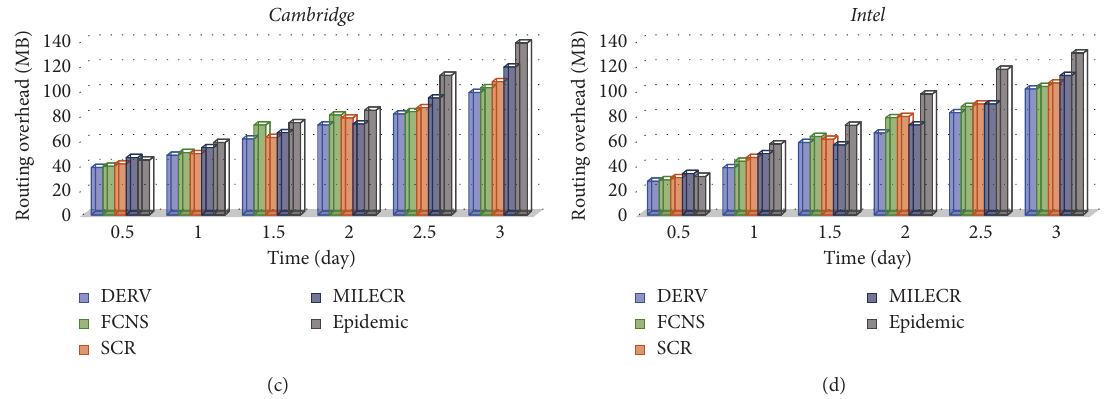
Figure 5: (a, b) The routing overhead of the DERV, FCNS, SCR, MILECR, and epidemic algorithms on datasets Infocom5, Infocom6, Cambridge,